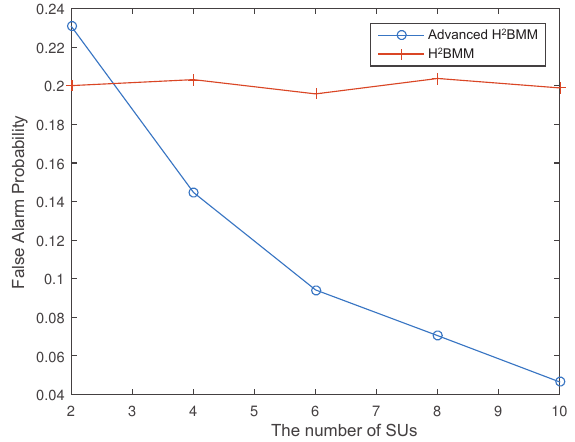
Figure 12. False alarm of Advanced H 2 BMM and H 2 BMM